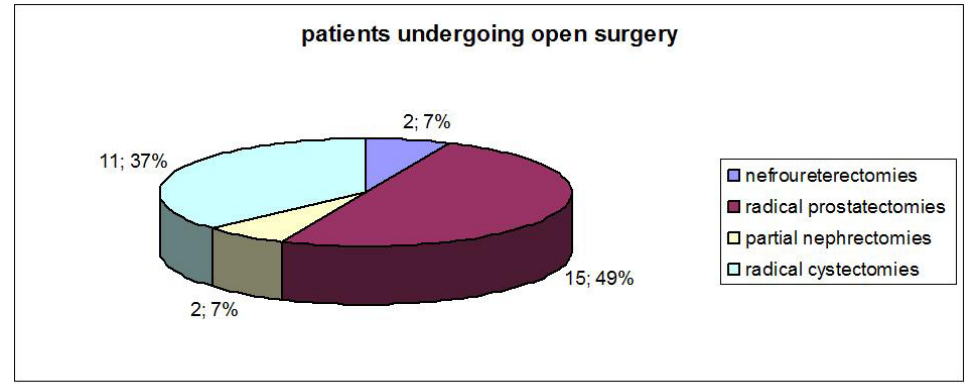
Figure 2: Patients undergoing open